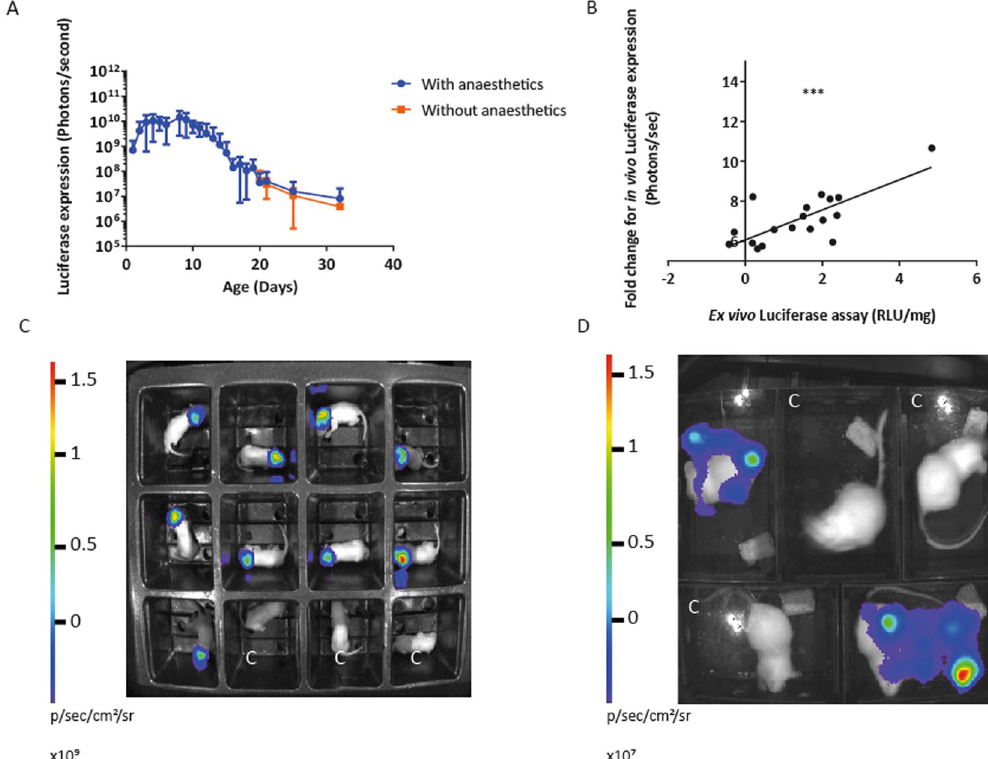
Figure 1. Intracranial neonatal administration of VSV-G SFFV lentiviral biosensor, with mean bioluminescence quantified from anaesthetised and non-anaesthetised mice. Mice received the VSV-G pseudotyped lentivirus vector containing the constitutive SFFV promoter, at birth via intracranial injections (n = 9). They were imaged daily, without anaesthetic, until 21 days old. ( A ) Mean bioluminescence was quantified. The mice were then allocated randomly into two groups and whole-body bioluminescence imaging was undertaken either with or without isoflurane anaesthesia. There was no significant difference in luciferase expression between the two groups, (mean + / − SD, P = 0.657). ( B ) New born mice received an intracranial injection of VSV-G SFFV lentiviral vector. Over the course of development mice were bioimaged and brain tissue from three mice was collected at weekly time points for ex vivo luminometry (n = 3). A strong positive correlation was observed between the fold change of in vivo luciferase expression at the time of euthanasia and ex vivo luciferase expression, P = 0.0003, R 2 = 0.5690. ( C ) Imaging of neonatal mice and ( D ) adult mice without anaesthetic, mice marked with C are control mice which have not received vector. The region of interest (ROI) used to quantify conscious neonatal mice in each enclosure, was 5 cm by 5 cm. Once the mice had reached adult hood the ROI for both conscious and unconscious mice was 9 cm by 12.5 cm. The exposure time for each bioluminescent image quantified was 1